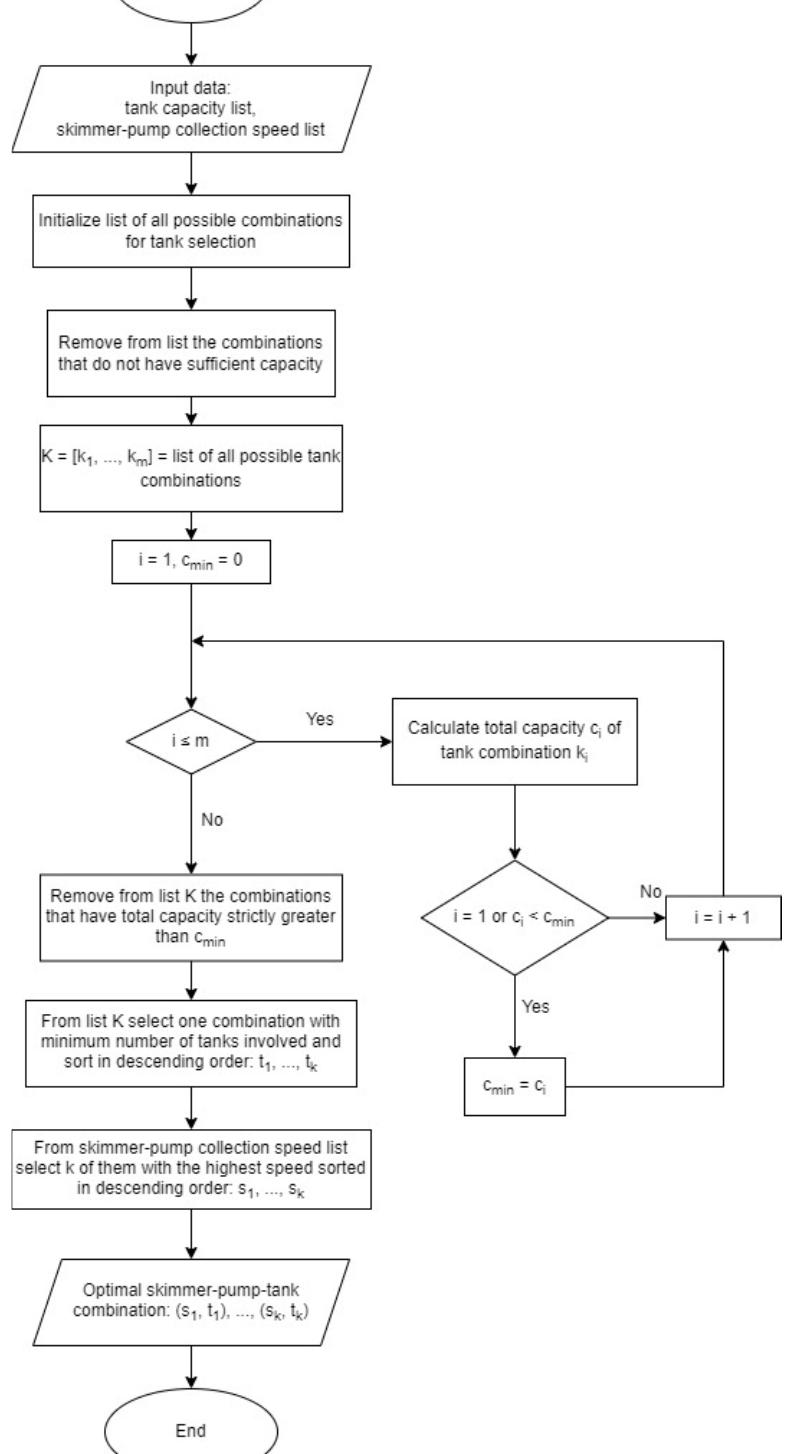
Figure 8 . Storage optimisation algorithm flowchart. Figure 8. Storage optimisation algorithm